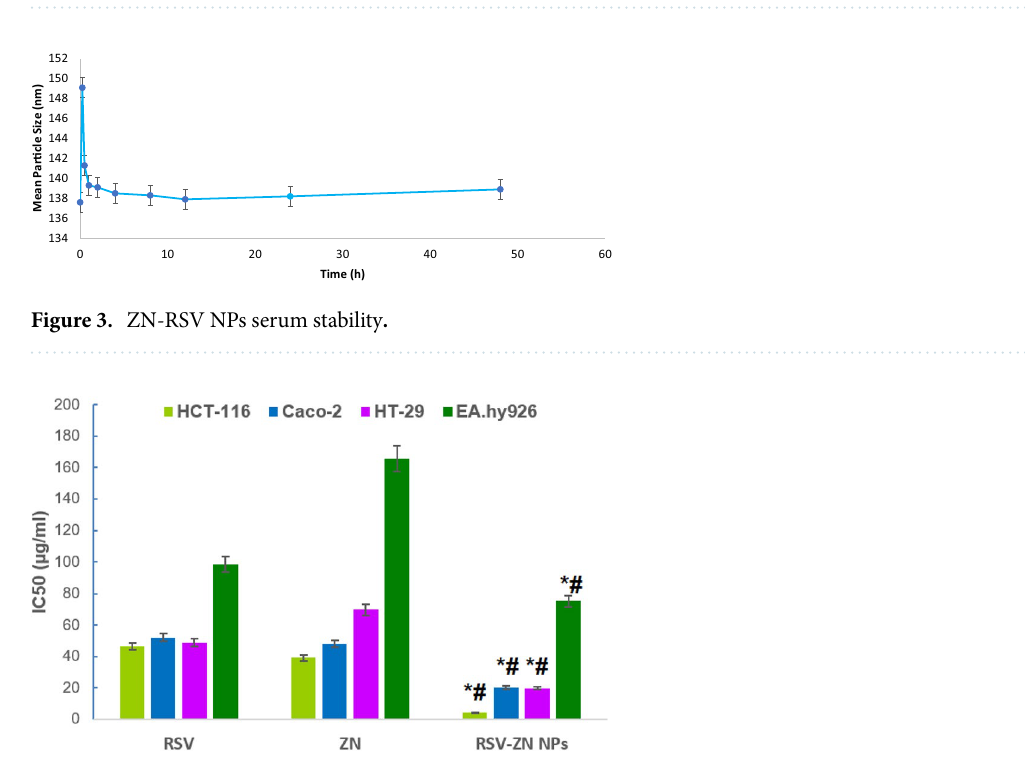
Figure 2. SEM image of ZN-RSV NPs.